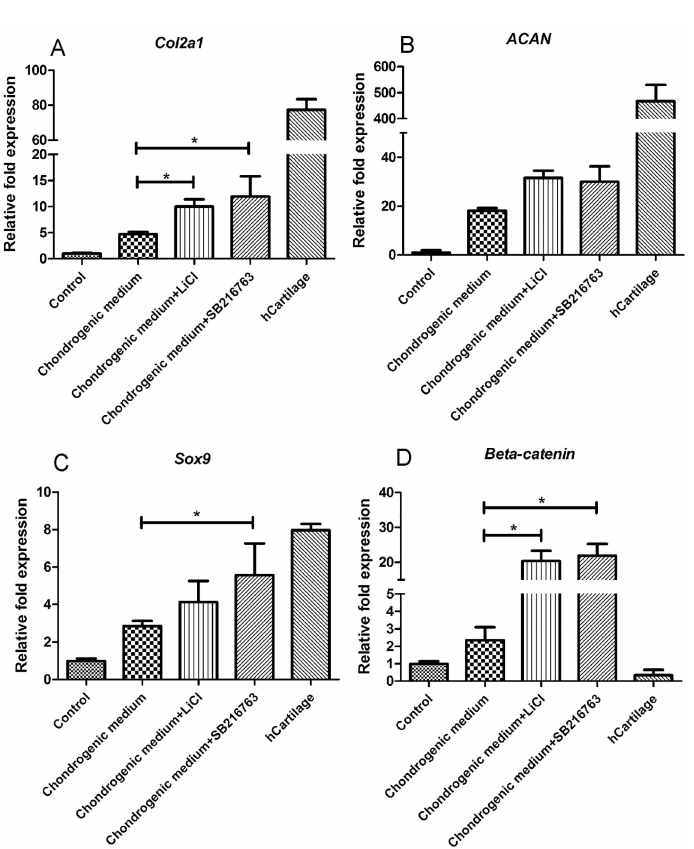
Fig 7. qPCR analysis for chondrogenic gene expressions after 4 weeks of inductions. (A) Col2a1 , (B) ACAN , (C) Sox9 and (D) β -catenin .Gene expressionwas normalized to coresponding GAPDH and calculatedby relative expressioncomparedto control cells. The experiments were perfromed three times. ** Datawere expressedas mean ± SD, * P < 0 . 05